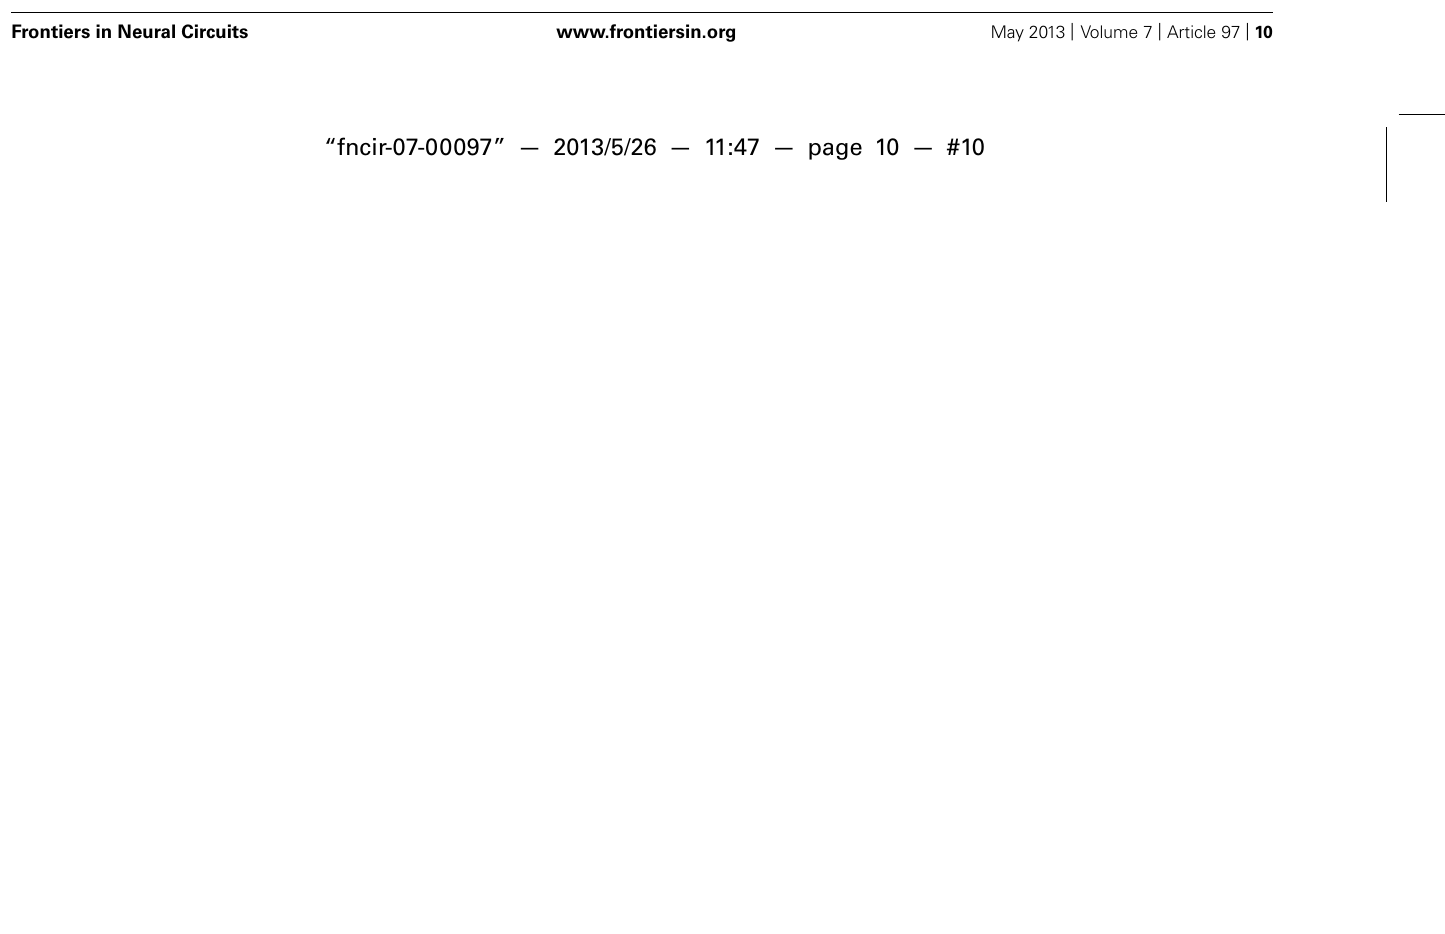
FIGURE 5 | Principal component analysis. (A) The percent variance captured by each component of the SVD analysis of protein expression in rat visual, somatosensory, and frontal cortex.The first three principal components represent the significant portion (99%) of the SVD. (B–D) The influence of each protein on the three principal components was reflected by the relative amplitude in the basis vectors. (E) Significant